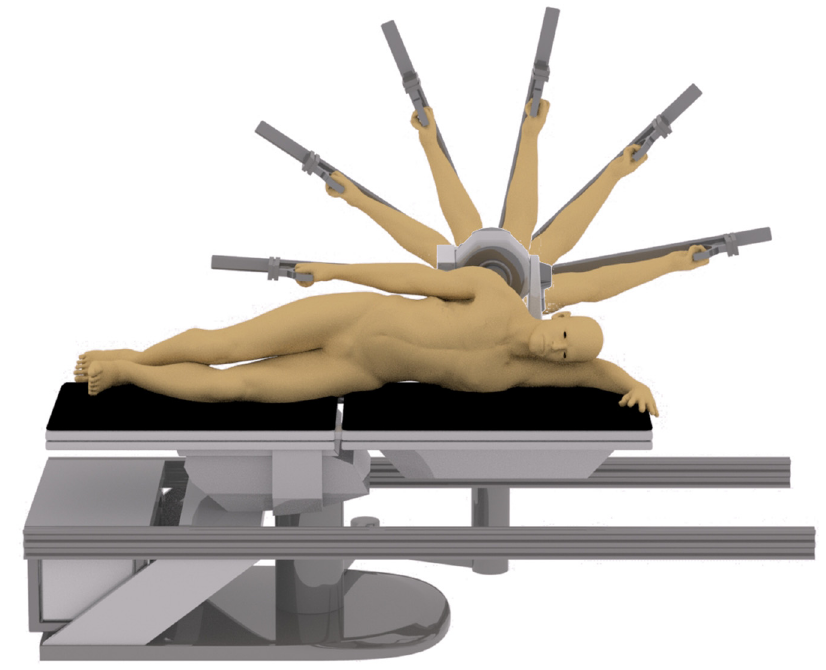
Figure 1. Shoulder flexion/extension isokinetic motion.